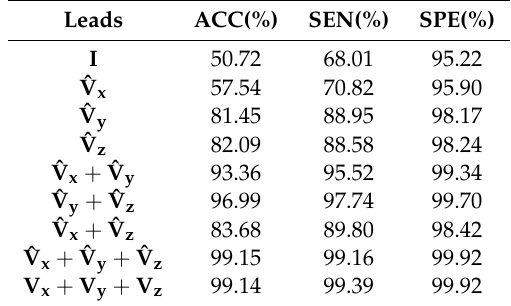
Table 8. Classification results of MLP classifier with various lead configurations.